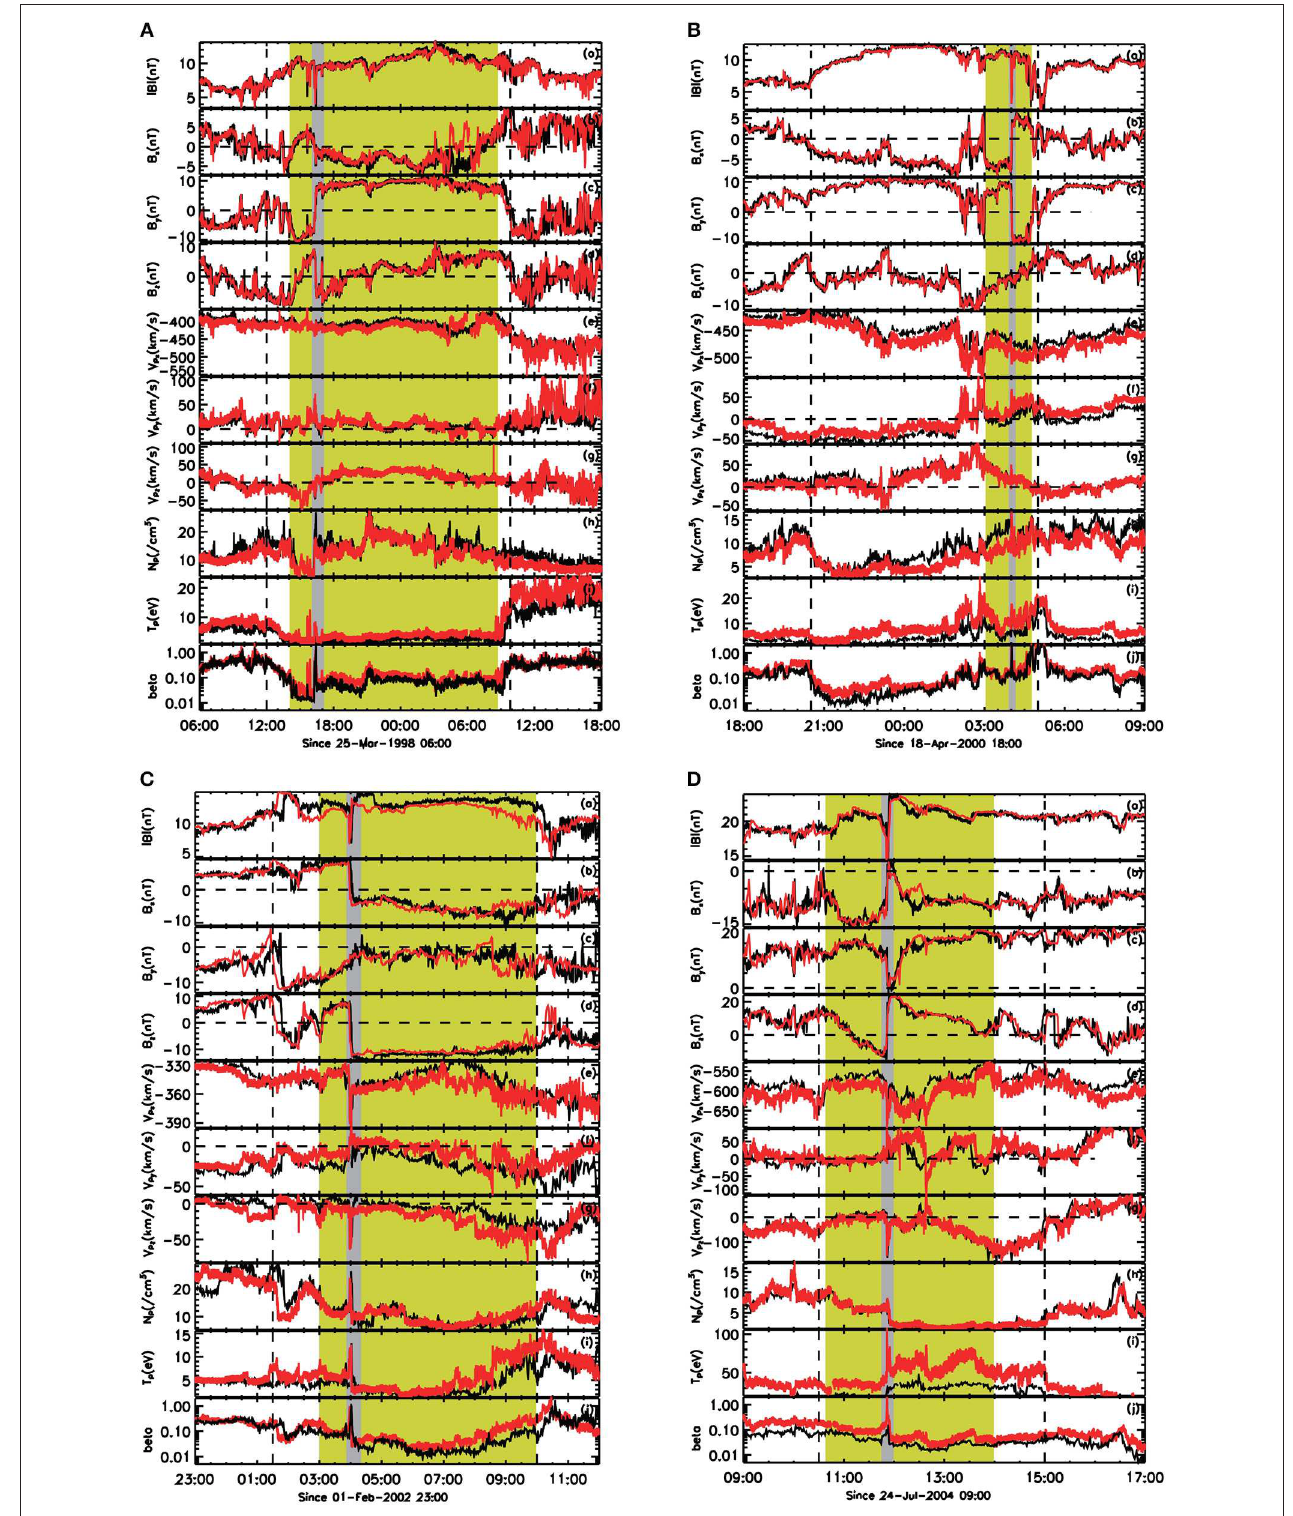
FIGURE 3 | The other four ICMEs in Mar. 1998 (A) , Apr. 2000 (B) , Feb. 2002 (C) , and Jul. 2004 (D) . The observations of ACE have been shifted 5min for case A (28min for case B , 147min for case C , − 13min for case D ) forward. For each case, the figure format is similar to Figure 1 .